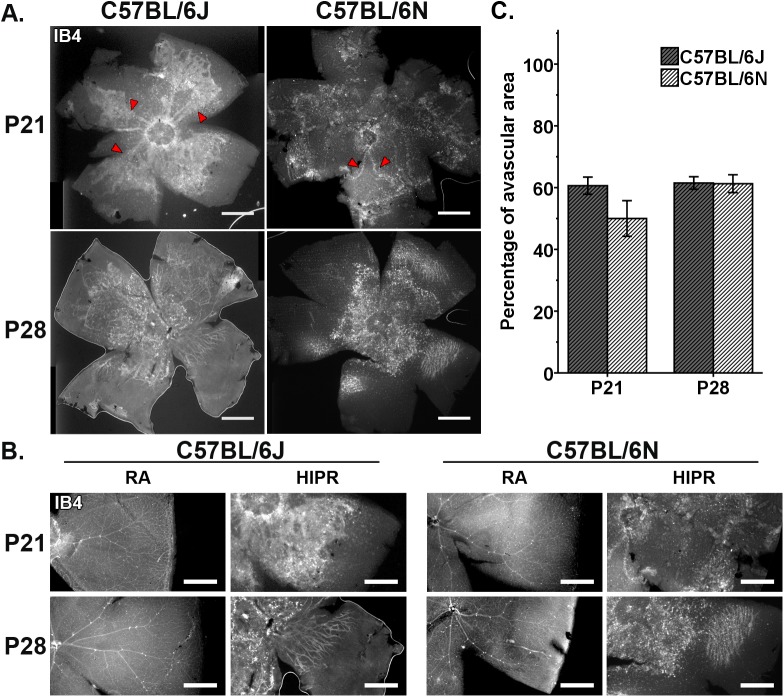
Absence of normal patterning of the retinal vasculature and disorganized angiogenesis in both strains of hyperoxia-induced proliferative retinopathy (HIPR).Representative retinal flat mounts from P21 and P28 HIPR were stained with an endothelial cell marker, IB4. (A) There is a complete absence of normal pattern retinal vasculature in HIPR of both strains. (B) Persistent hyaloid vessels (red arrowheads) were observed in the retinal mid-periphery in C57BL/6N and C57BL/6J at P21 and P28. Scale bar, 500 μm (N = 3–6). (C) There are no strain differences in the percentage of avascular area measured from the flat mounts.